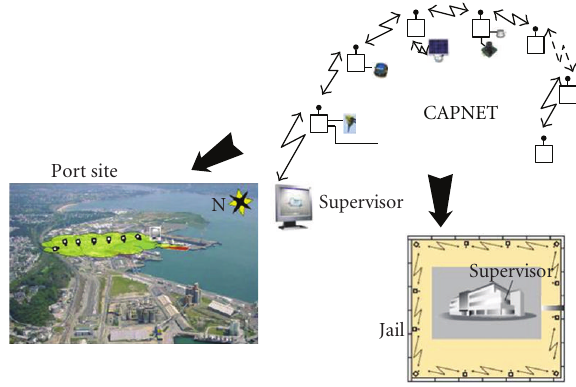
Figure 1: Examples of application.